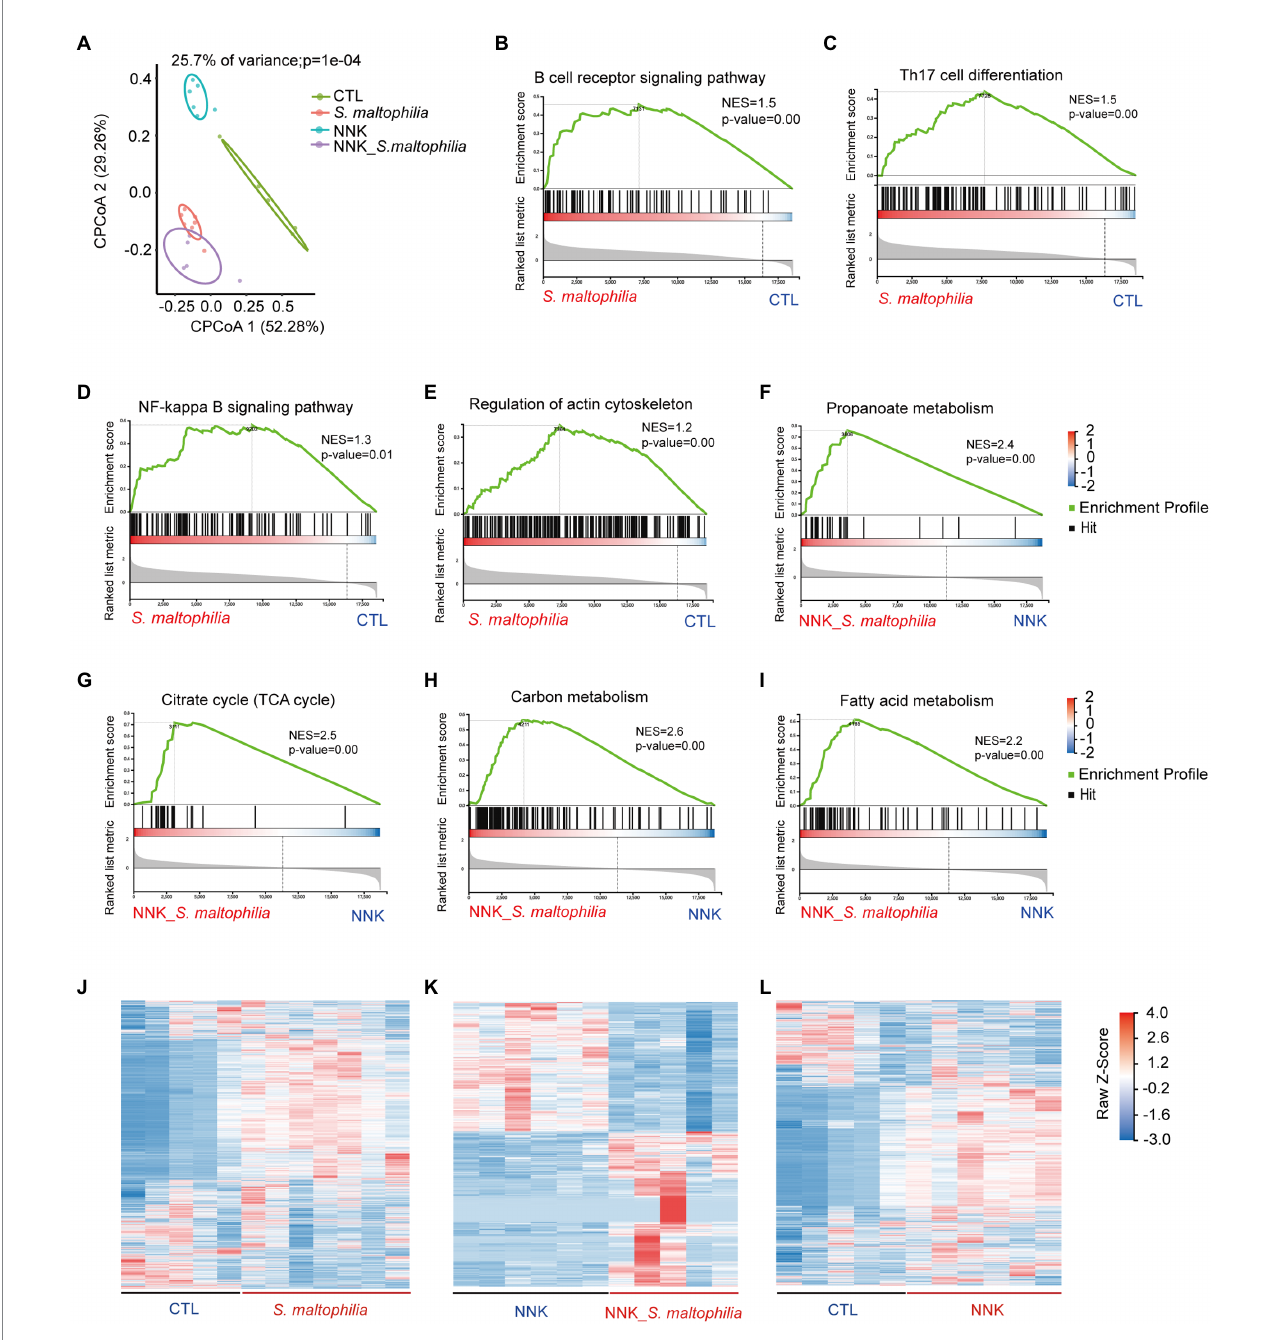
FIGURE 3 Stenotrophomonas maltophilia modulates gene expression in lung tissues by RNA-seq analysis. (A) Constrained PCoA clustering analysis of RNA-seq data. (B–I) GSEA Plot for the B cell receptor signaling pathway, Th17 cell differentiation, NF-kappa B signaling pathway, regulation of actin cytoskeleton, Propanoate metabolism, Citrate cycle (TCA cycle), Carbon metabolism, and Fatty acid metabolism, respectively. (J) Heatmap of different genes in lung tissues of S . maltophilia group compared with CTL group. (K) Heatmap of different genes in lung tissues of NNK_ S . maltophilia group compared with NNK group. (L) Heatmap of different genes in lung tissues of NNK group compared with CTL